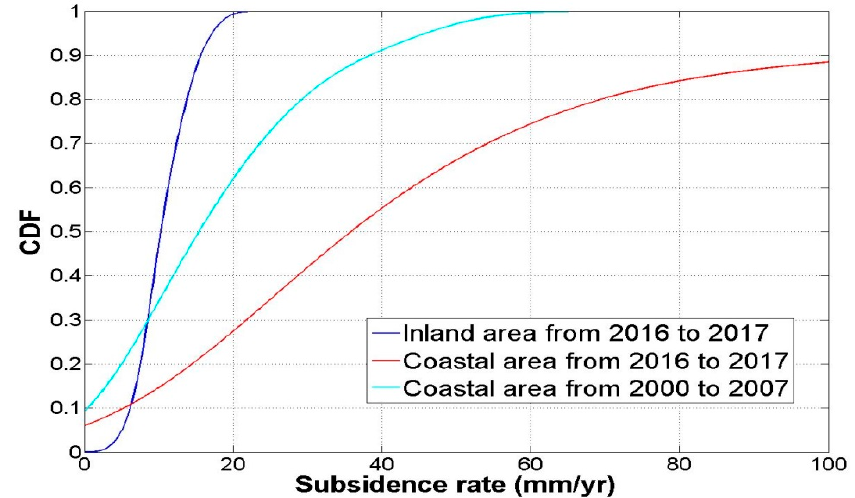
Figure 9. Cumulative distribution functions (CDF) of the subsidence rates in two periods.